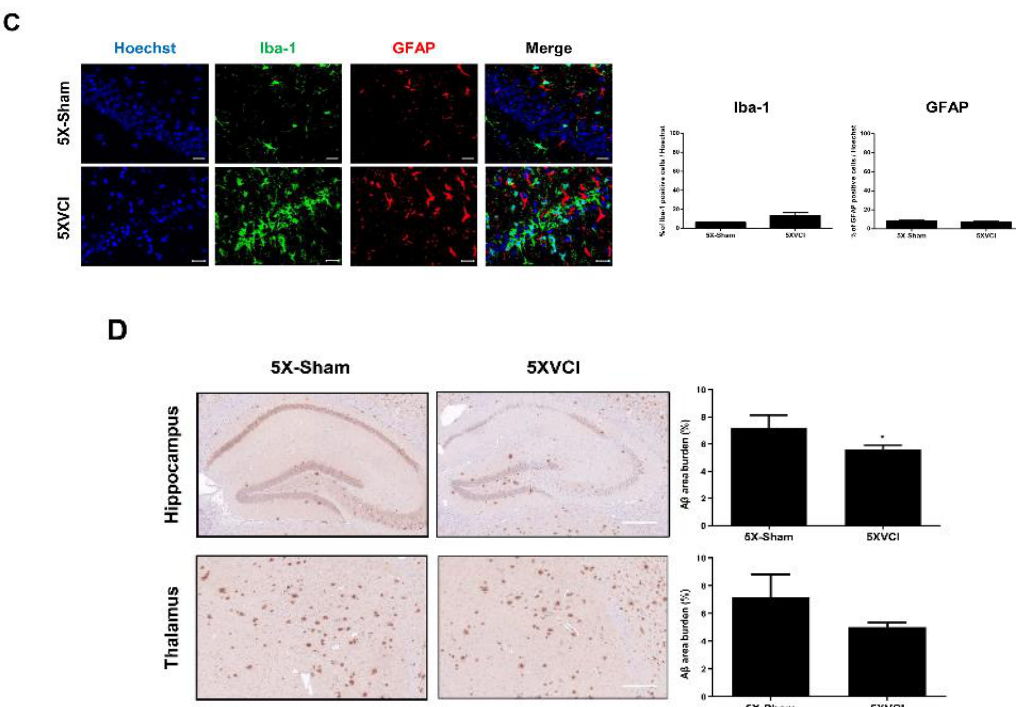
Figure 6. Assessment of changes in neuronal density, microglial / astrocyte activity, and amyloid burden of 5XVCI mice. ( A ) According to the Y-maze results, an impairment in spatial working memory was not observed from the 5XVCI mice. ( B )According to NeuN immunostaining (green), a significant reduction in hippocampal neuronal density was observed from the 5XVCI group. * p < 0.05 vs.5X-Sham; mean ± S.E.M, scale bar = 20 µ m. ( C ) Significant changes in microglia and astrocyte activities were not observed from the double immunostaining of Iba-1 (green) and GFAP (red) markers, respectively. Mean ± S.E.M, scale bar = 20 µ m. ( D ) There was a significant reduction in 6E10 immunoreactivity in the hippocampi of 5XVCI mice compared to the 5X-Sham mice. * p < 0.05 vs.5X-Sham; mean ± S.E.M, scale bar = 200 µm.